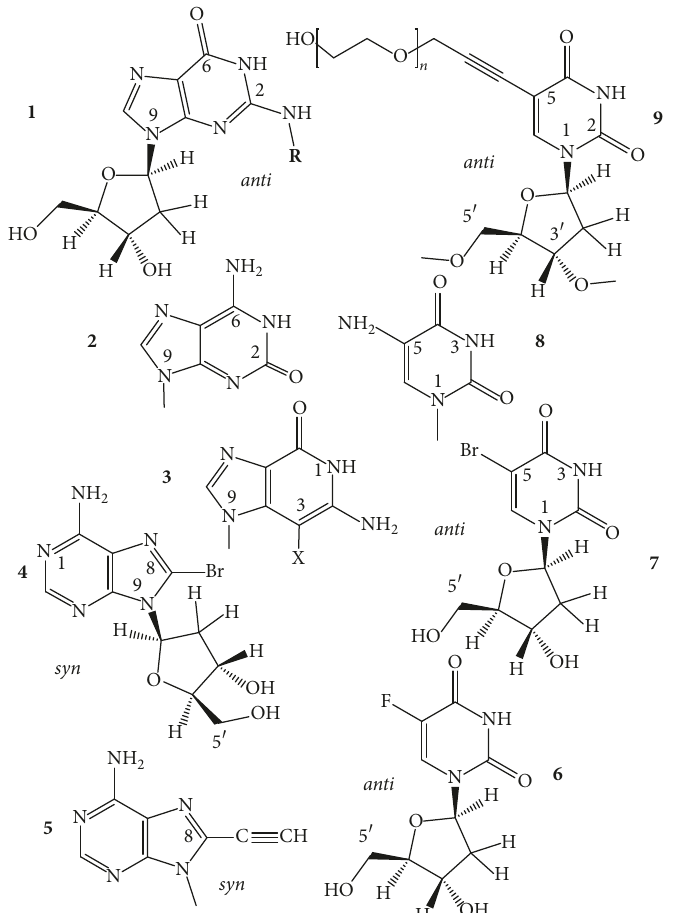
Figure 4: Structures of the anti N2-substituted-dG ( 1 ); isoguanine ( 2 ); 3-halo-3-deazaguanine ( 3 ); syn 8-bromo-dA ( 4 ); 8-propynyladenine ( 5 ); anti 5-fluoro-dU ( 6 ); anti 5-bromo-dU ( 7 ); 5-aminouracil ( 8 ); and oligo(ethylene glycol) substituted anti 5-propynyl-dU ( 9 ).